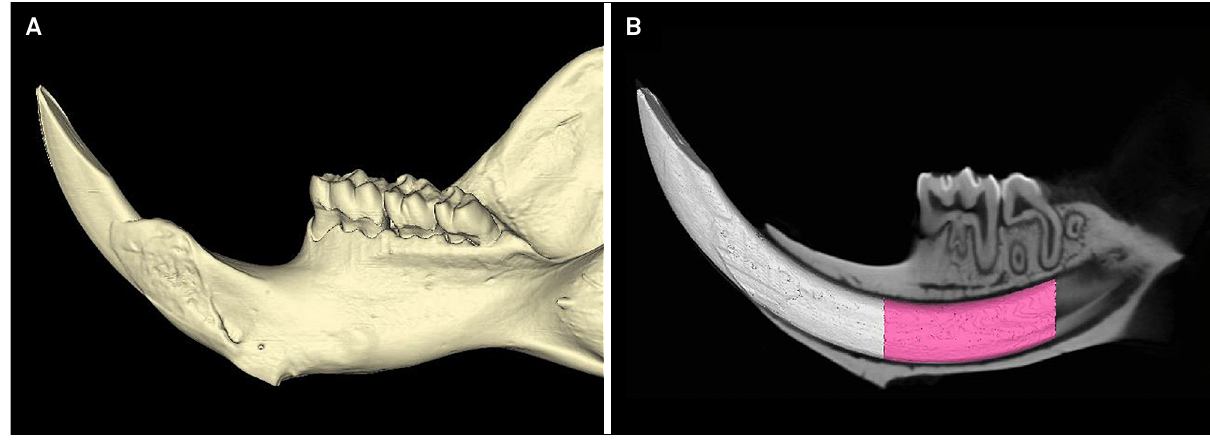
Figure 1. Three-dimensional reconstruction of the entire mandible (A) and segmentation of the mandibular incisor (B) with the highlighted volumetric region of interest comprised between the second molar distal surface and the digastric muscle insertion to the mandible (pink